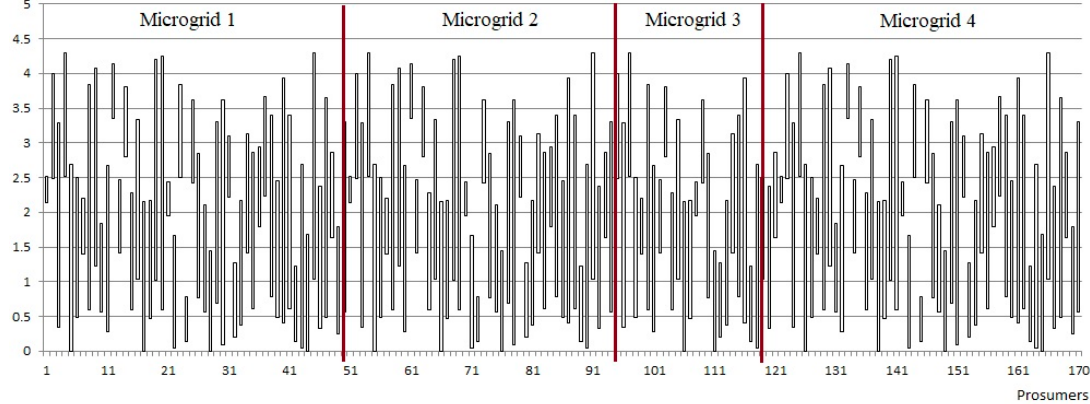
Figure 5. Portfolio of small scale prosumers considered with minimum and maximum energy consumption of each individual prosumer.